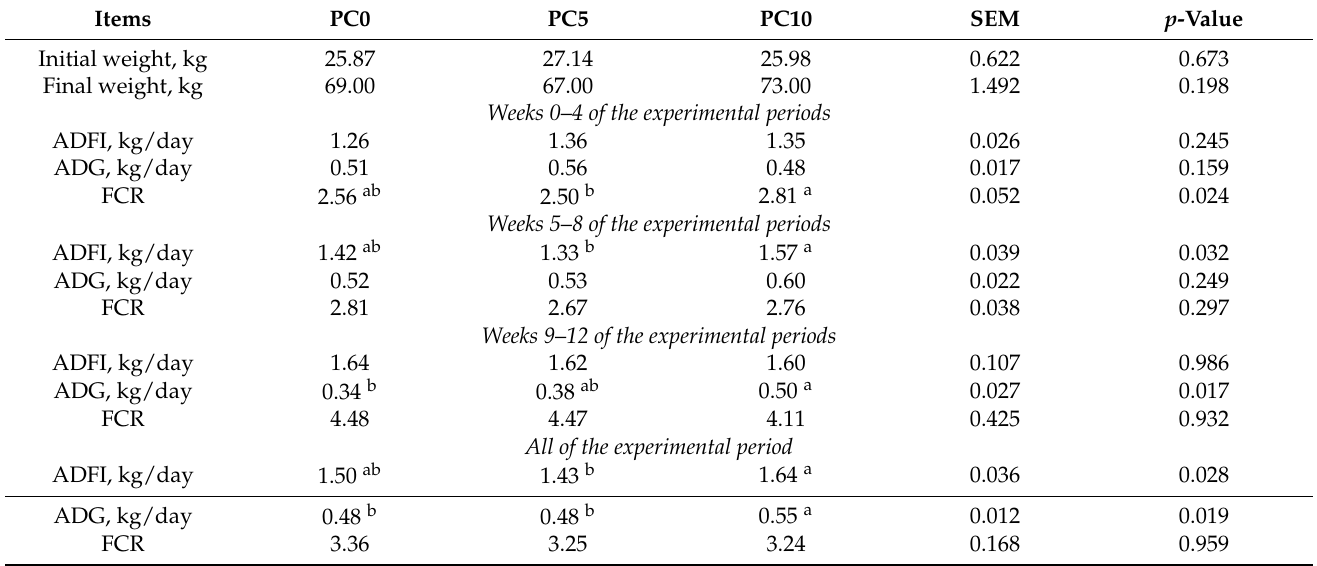
Table 3. Effect of dietary perilla cake supplementation on the productive performance of growing